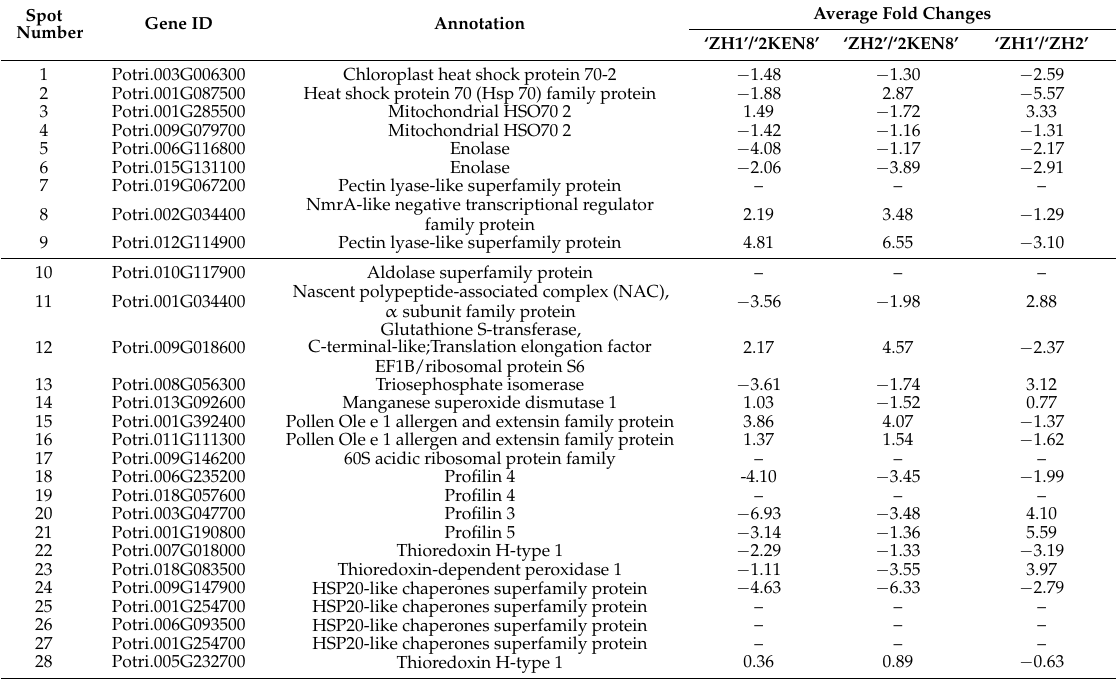
Table 2. Differential expression of 28 candidate allergenic